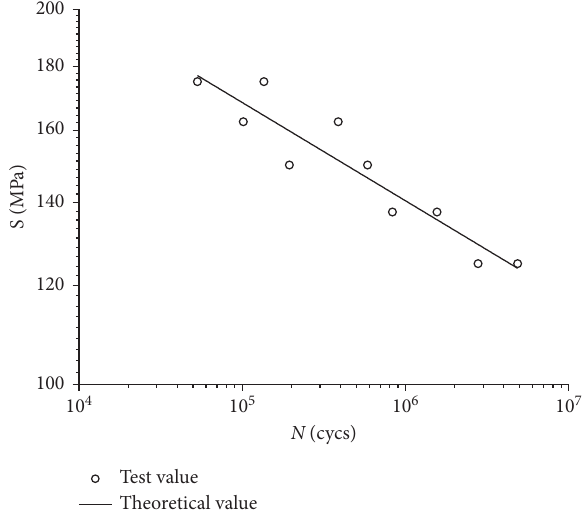
Figure 17: Relationship of stress amplitude versus fatigue life of welded specimens. Figure 18: Histogram of stress amplitudes.